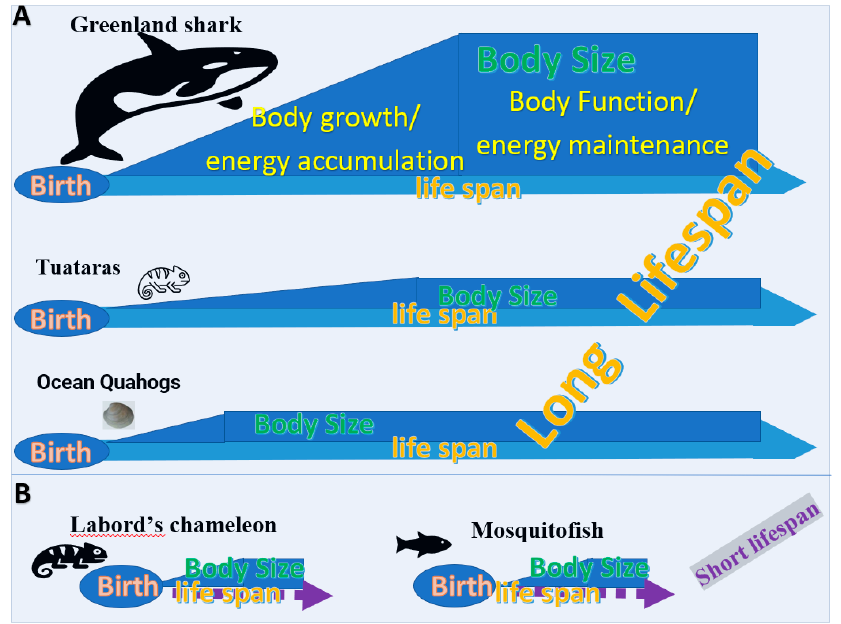
Figure 4. Examples of different lifespans in animals. ( A ) Three ways of achieving a long lifespan in the life cycle. The Greenland shark achieves a long lifespan by continued growth into a large body size, which therefore leads to a long reproductive period. Tuataras experience a long lifespan mainly by their slow body growth and long reproductive period. Ocean quahogs experience a long lifespan mainly due to the longevity of their reproductive activity. ( B ) Two examples of animals with short lifespans. Both Labord’s chameleons and mosquitofish have short lifespans because of their rapid body maturation and short reproductive period.